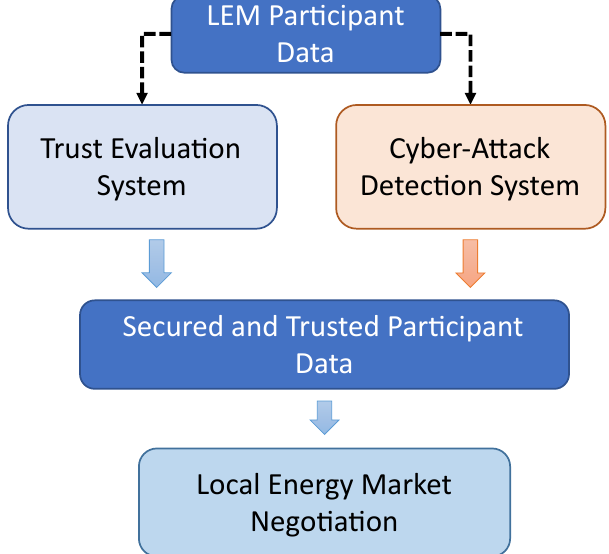
Figure 9. Trust and security